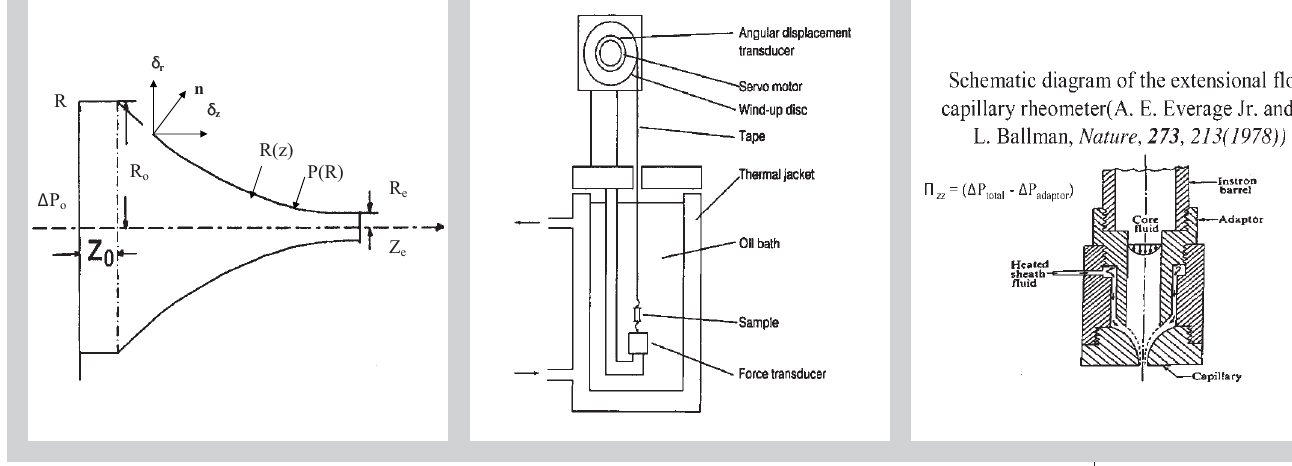
Figure 1 (left): Schematic of the semi- hyperbolic die following Collier and coworkers (1998). Flow is from left to right and the pressure at the entrance is D P . o Figure 2 (middle): Extensional rheometer of the Münstedt design for polymer melts Figure 3: Schematic drawing of the extensional flow capillary rheometer [Ballman and Everage